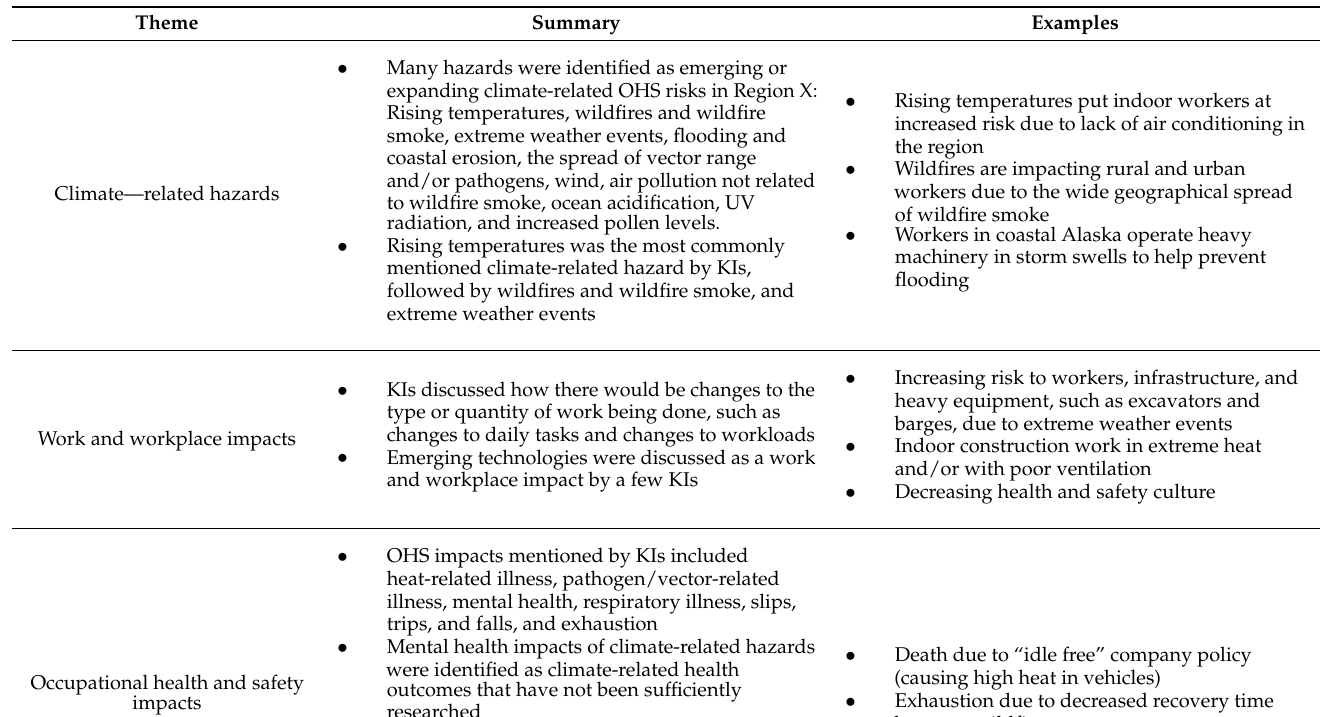
Table 2. Key Themes Summary with Specific